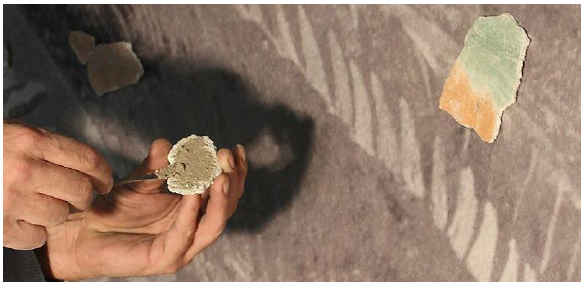
Figure 14. On the left: assembling of the fragments on the support